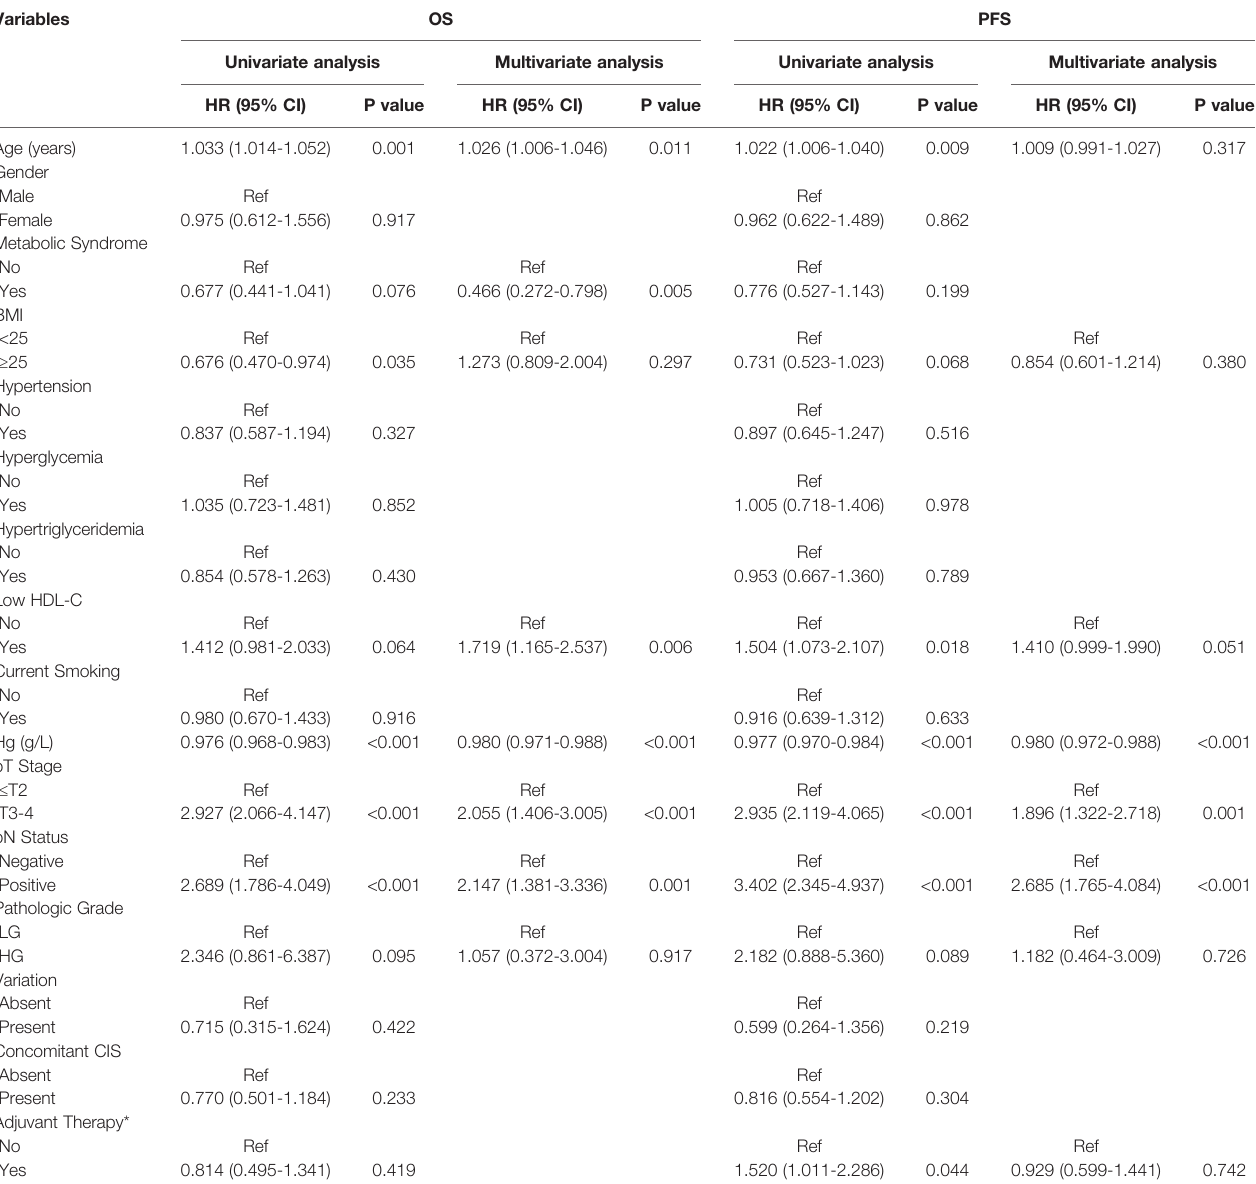
TABLE 2 | Univariate and multivariate analysis of prognostic factors using the Cox proportional hazards model for OS and PFS in all patients.